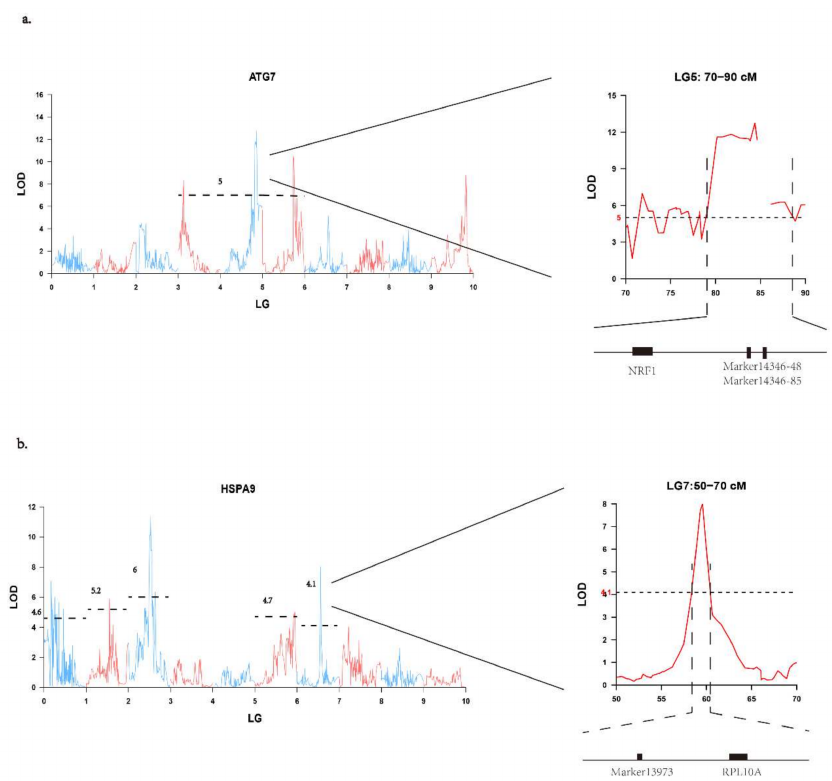
Figure 2. Plots of expression quantitative trait loci (eQTL) mapping and candidate regulatory loci and genes HSPA9 and ATG7 . ( a ) eQTL mapping of HSPA9 . ( b ) eQTL mapping of ATG7 . The black horizontal dashed line on each plot represents the chromosome-wide threshold of significance. Black rectangles represent candidate genes. Black vertical lines represent the regulatory single nucleotide polymorphism (SNP).